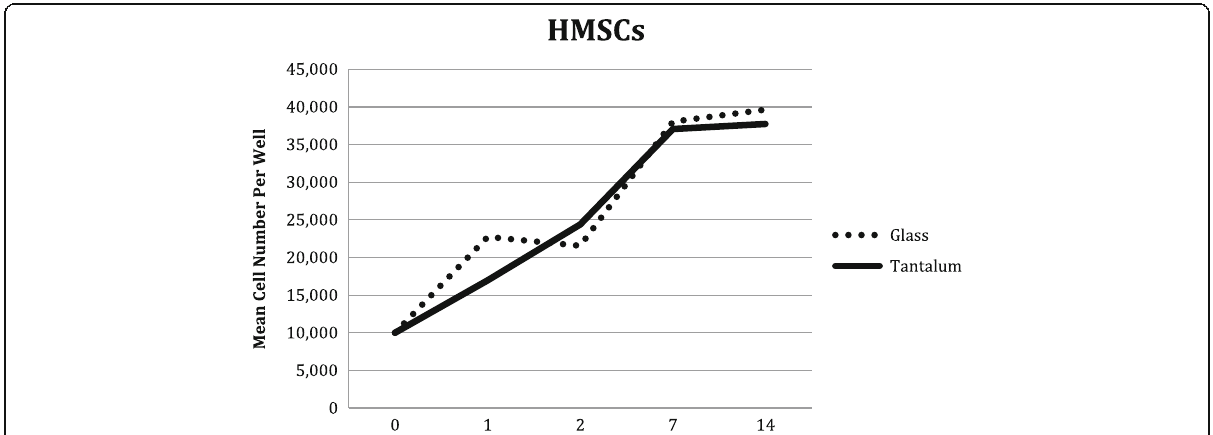
Fig. 3 Human Mesenchymal Stem Cell (HMSCs) proliferation on glass and tantalum-coated glass substrates at 0, 1, 2, 7 and 14 days culture